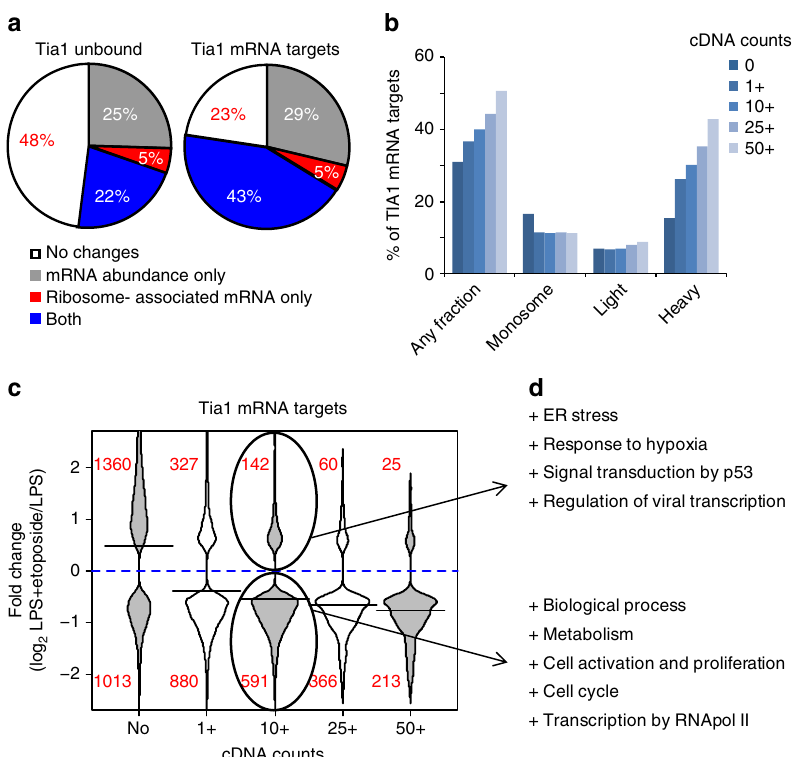
Fig. 3 Tia1 mRNA targets are highly responsive to DNA damage. a Proportion of Tia1 mRNA targets compared to non-targeted mRNAs that are differentially expressed in total mRNA abundance, in ribosome-associated or both after B-cell treatment with etoposide. Tia1 mRNA targets were de fi ned as those mRNAs in which > 50 unique cDNA counts were mapped to the 3 ′ UTR in our Tia1 iCLIP experiments. b Proportion of Tia1 mRNA targets with a signi fi cant change in any polysome fraction, in monosomes, light or heavy fractions. Tia1 mRNA targets were divided based on the number of unique cDNA counts mapped to the 3 ′ UTR (1+, 10+, 25+or 50+). Tia1 untargeted mRNAs were classi fi ed as having none (0) cDNA counts mapped to the 3 ′ UTR. c Distribution analysis of the fold change in ribosome-associated mRNA abundance of differentially expressed Tia1 mRNA targets compared to non-targeted mRNAs. Tia1 mRNA targets were sub-divided as in b . d Gene ontology (GOrilla and REViGO) analysis of Tia1 mRNA targets (10+ cDNA counts mapped to the 3 ′ UTR), which mRNA translation is increased or decreased after B-cell treatment with etoposide (extended in Supplementary Data